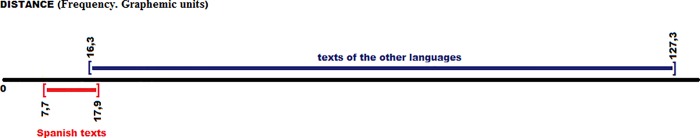
Distances between the Spanish or Castilian (average value) with all the texts of all the languages (graphemic units).